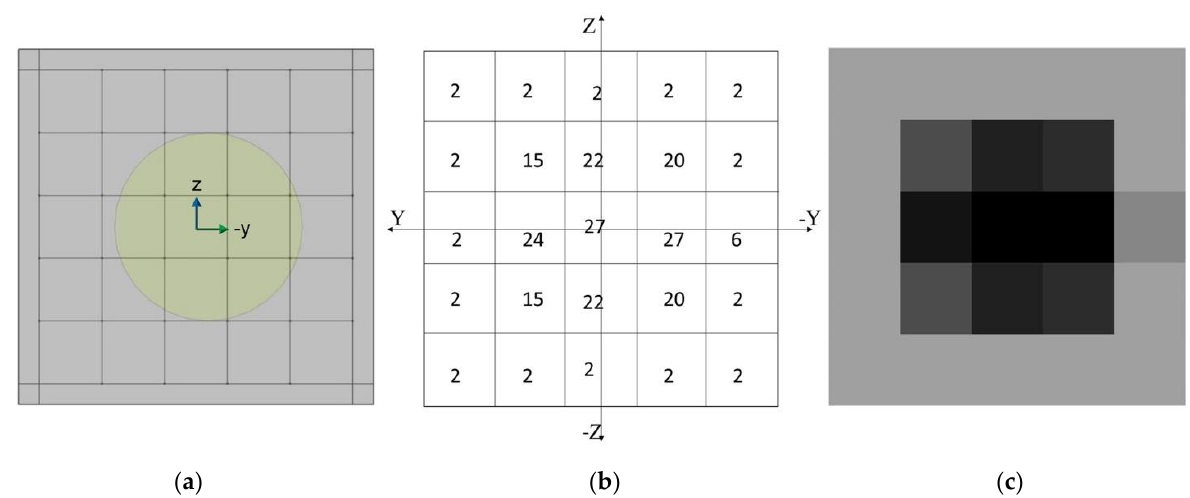
Figure 6. ( a ) Model geometry (YZ plane view); ( b ) peak density value of all pixels; ( c ) reconstructed image based on peak density.